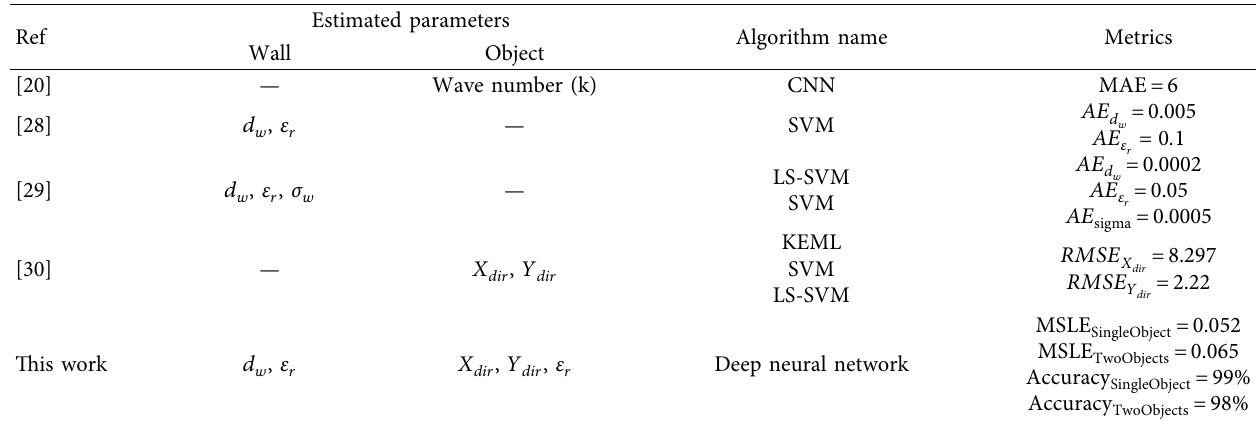
Table 4: A comparison of the results of this study with previous